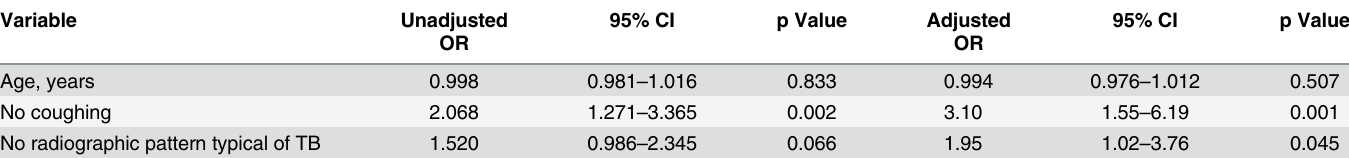
Table 2. Multivariate logistic regression model of risk factors associated with